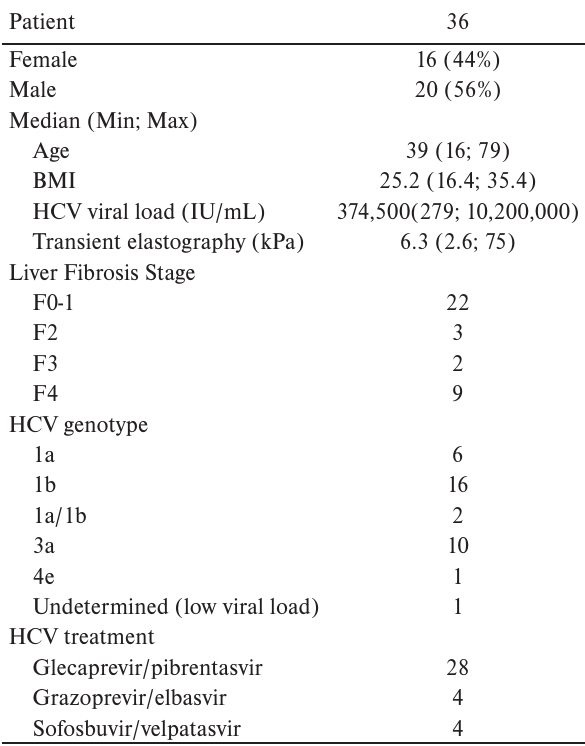
Table 1. Baseline characteristic of patients and DAA treatment